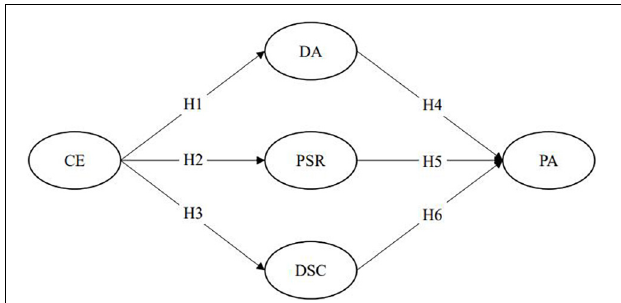
FIGURE 1 | CE = destination endorser credibility; DA = destination attitude; PSR = para-social relationship; DSC = destination source credibility; PA = place